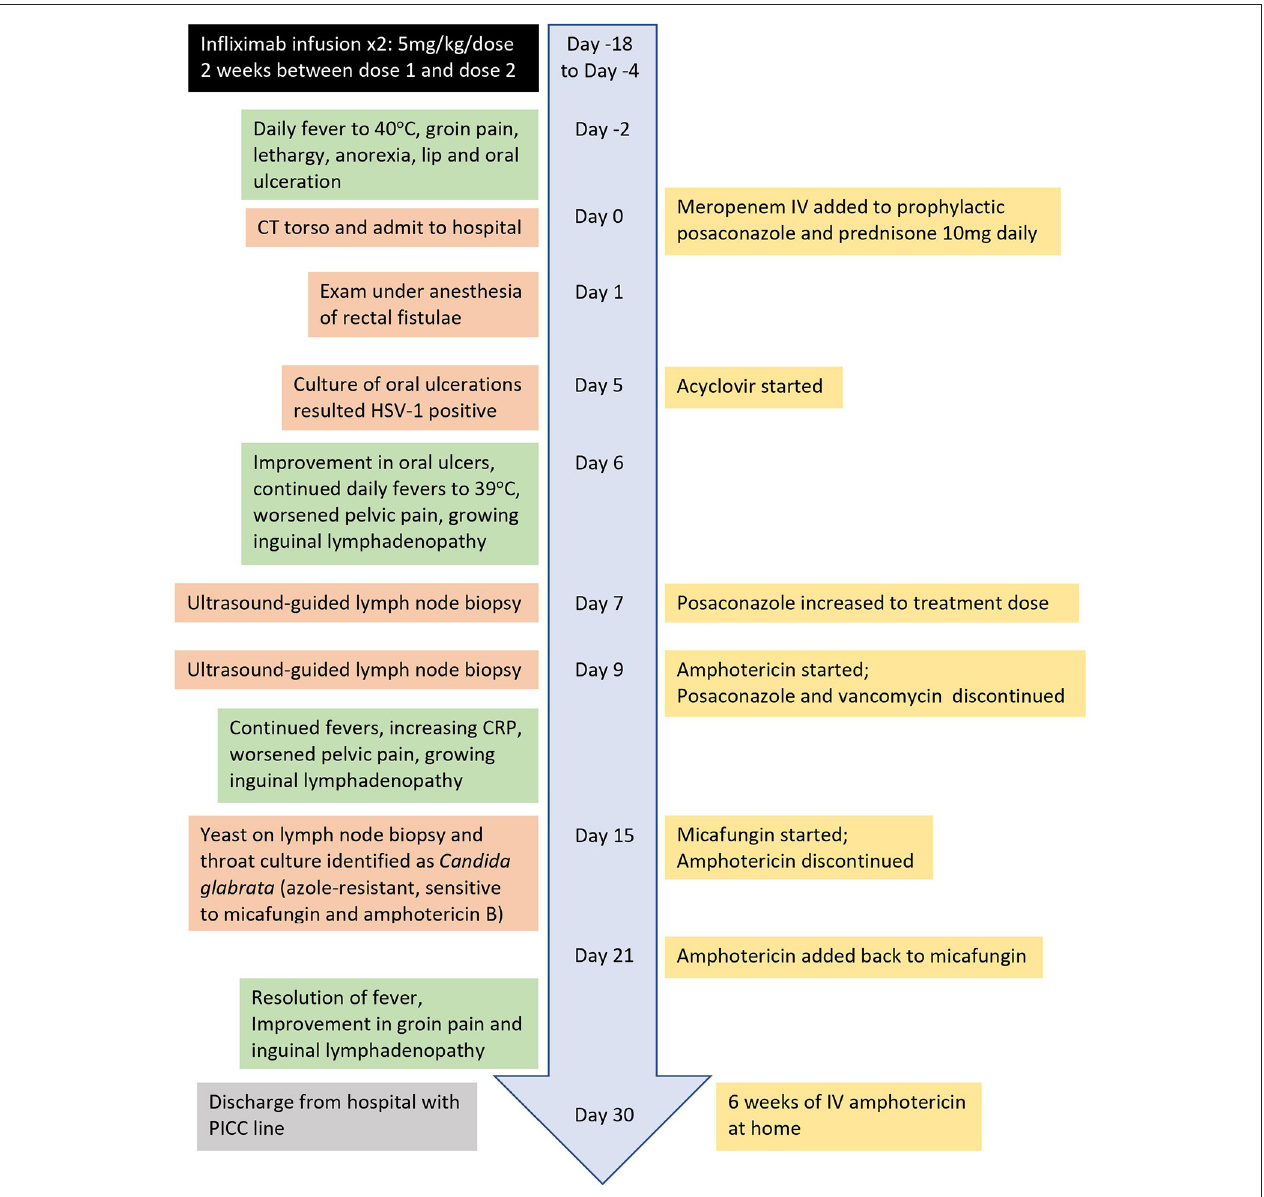
FIGURE 1 | Timeline of hospitalization for Candida glabrata